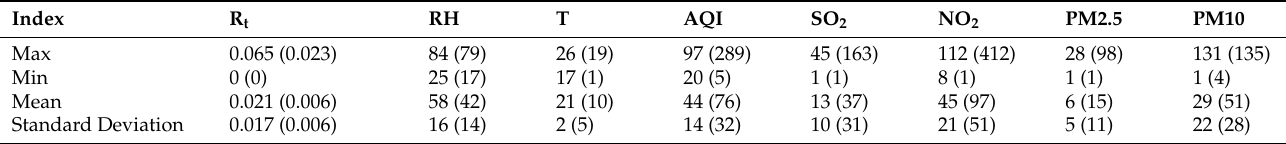
Table 2. Characteristics of the field data in Stage 1 (Stage